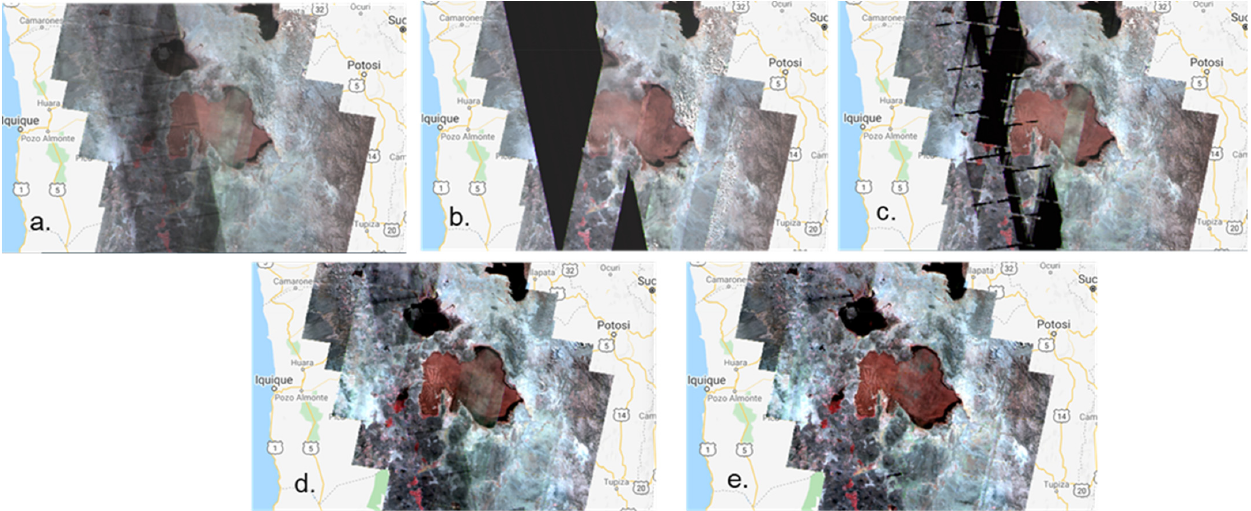
Figure 4. Different approaches to compositing ASTER scenes: ( a ) 2000–2006 May–September